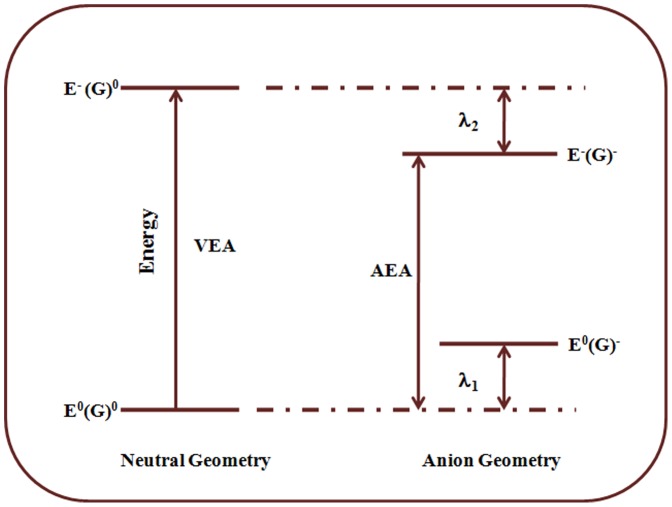
Calculation details of the reorganization energy (eV) for the electron transport, λ1 is reorganization energy of a neutral molecule and λ2 reorganization energy of a anionic-radical.